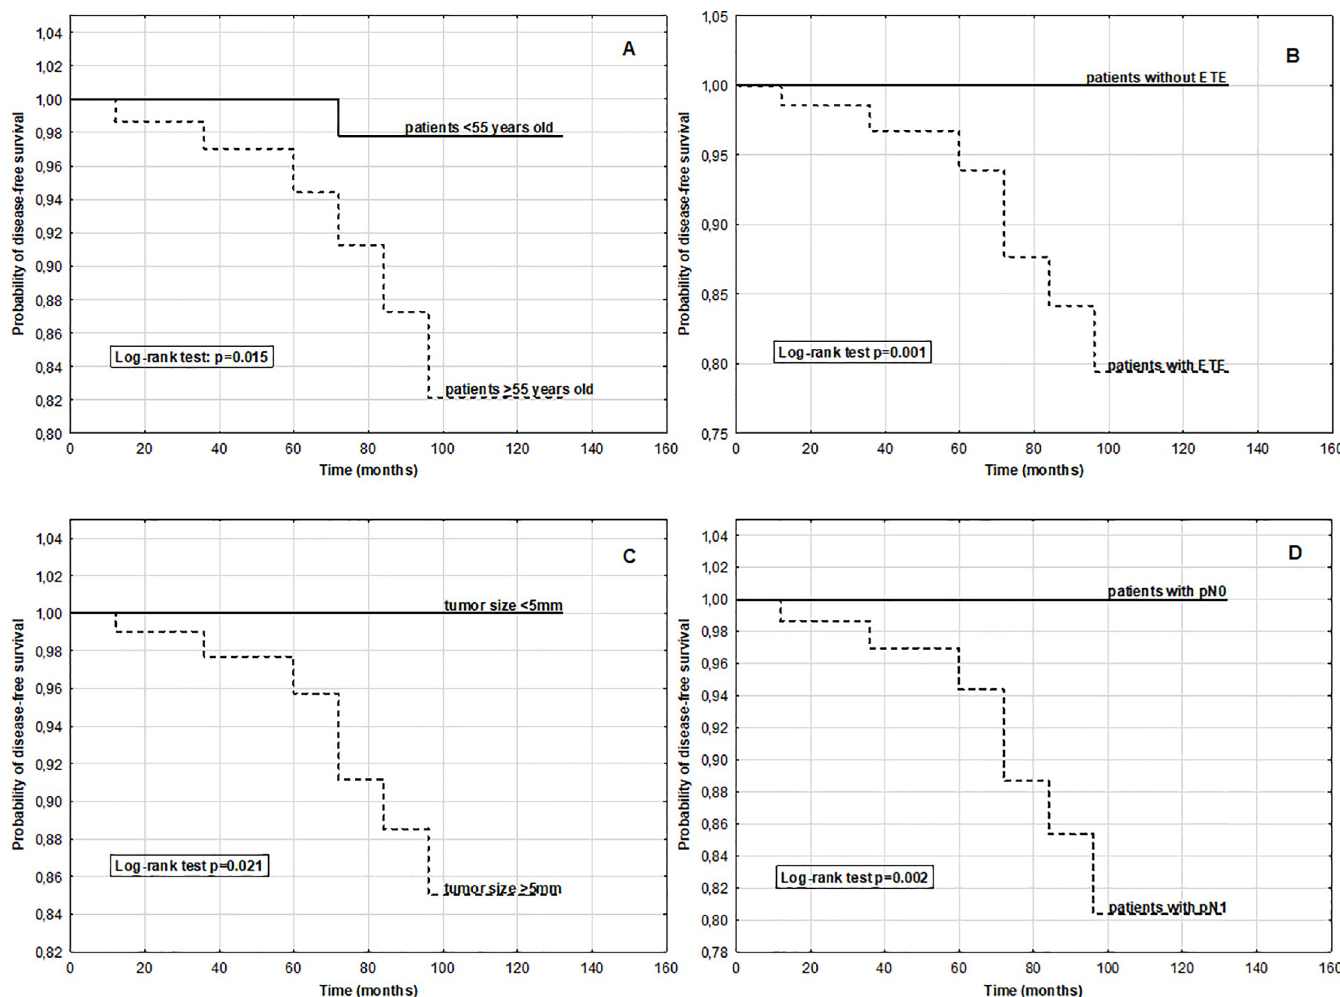
Fig 2. Time of cancer recurrence for PTMC patients according to age and selected histopathological parameters. Kaplan-Meier curves showed significantly lower disease-free survival times for patients aged � 55 years (A), minimal extrathyroidal extension status (B), tumor size > 5 mm (C) and lymph node metastasis (D).